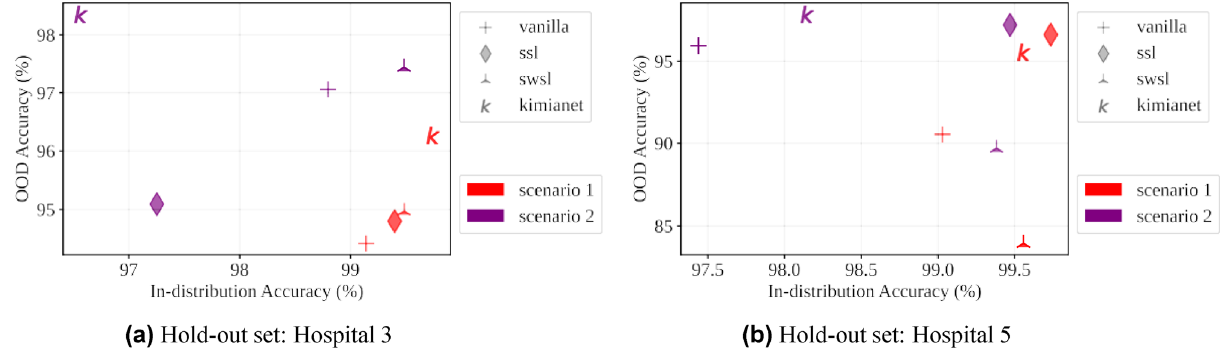
Figure 3. The OOD versus in-distribution top-1 accuracy for the model trained using scenario 1 versus scenario 2 for the hospitals 3 and 5 with significant distribution shift relative to other